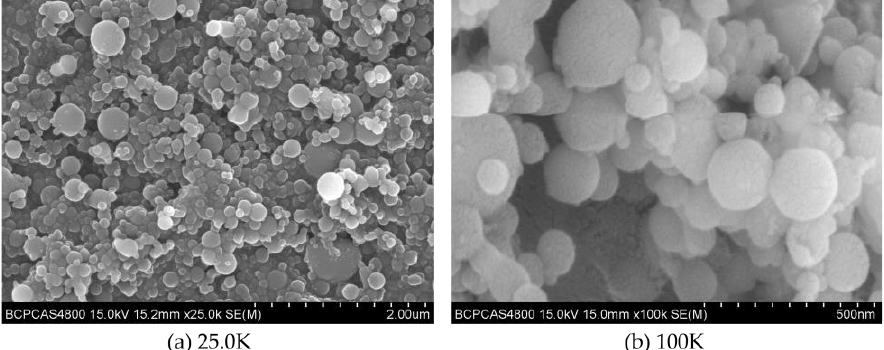
Figure 1. SEM image of C 8 H 18 -Al nanoparticles: ( a ) magnification 25.0 K, ( b ) magnification 100 K.